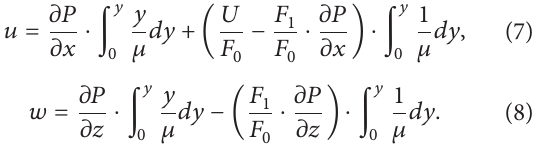
the thickness of the pad, ℎ 0 is the radial clearance, 𝛼 is the angular displacement of the pad, and 𝑥 𝑆 and 𝑦 𝑆 are the position of the shaft in the local referential system ( 𝑥 , 𝑦